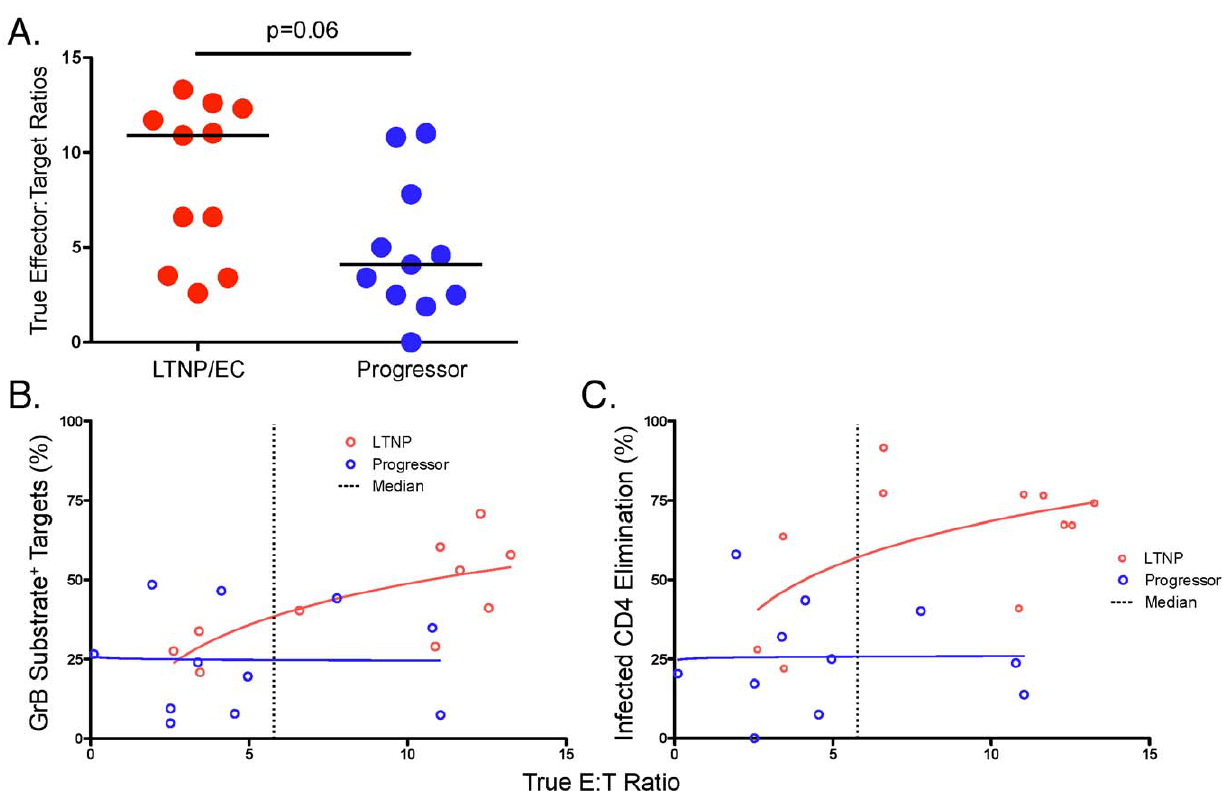
Figure 4. SIV-specific CD8 + T cells of LTNP/EC mediate greater per-cell killing of SIV-infected targets than those of progressors, which is not simply due to higher true E:T ratios. A. The true effector to target (E:T) ratios, determined by measurements of IFN- c -secreting CD8 + T-cell effectors and p27-expressing CD4 + T-cell targets, respectively, as described in the Methods and shown in the Figure S1 and Table S1, were compared between LTNP/EC (n=11) and progressors (n=11). Horizontal bars represent the median values. B, C. GrB target cell activity ( B ) or ICE ( C ) responses plotted against the true E:T ratios are shown for LTNP/EC (n=10, GrB target cell activity; n=11, ICE) and progressors (n=11). GrB target cell activity is shown after subtraction of background. The response curves were analyzed by regressing ICE and GrB on log true E:T ratios using analysis of covariance. The standard two-tailed t test from regression analysis was used to compare estimated GrB target cell activity and ICE of LTNP/EC with that of progressors at the 5.8 E:T ratio, the median of the combined E:T ranges of both